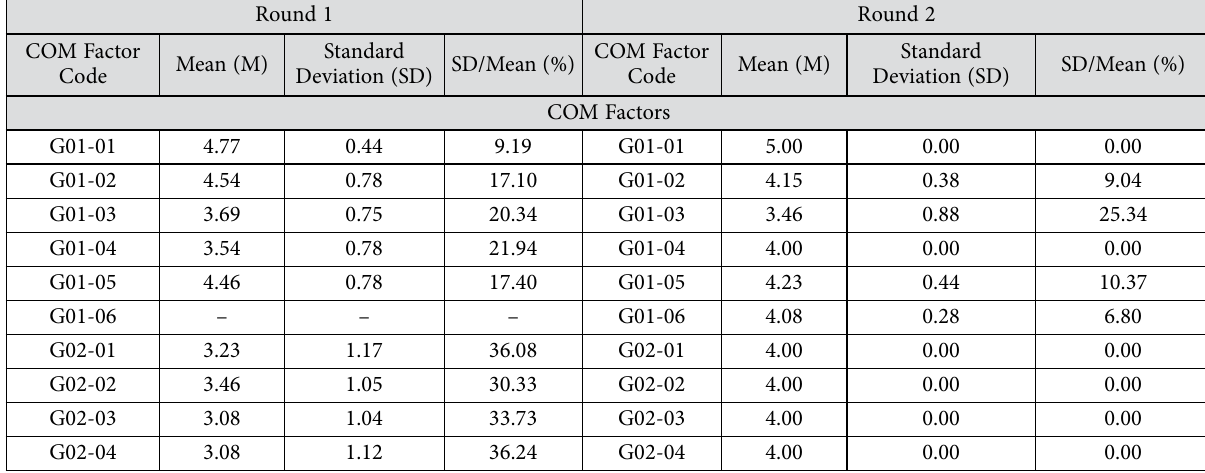
Table 5. Measurement of consensus for COM factors and groups based on SDMR – Rounds 1 and 2 Round 1 Round